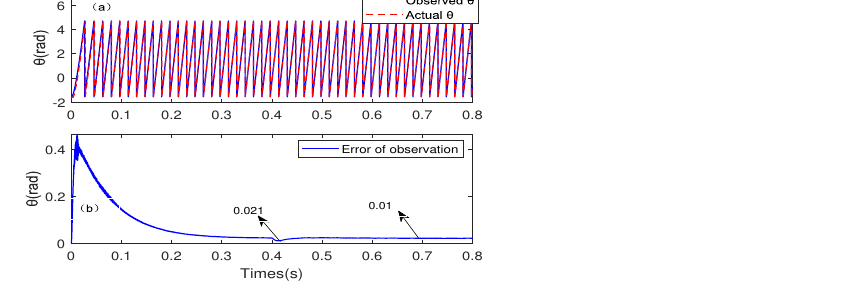
Figure 26. The estimation of rotor position Angle using VPDPI. ( a ) Observed and actual rotor position Angle. ( b ) Rotor position Angle observation error.